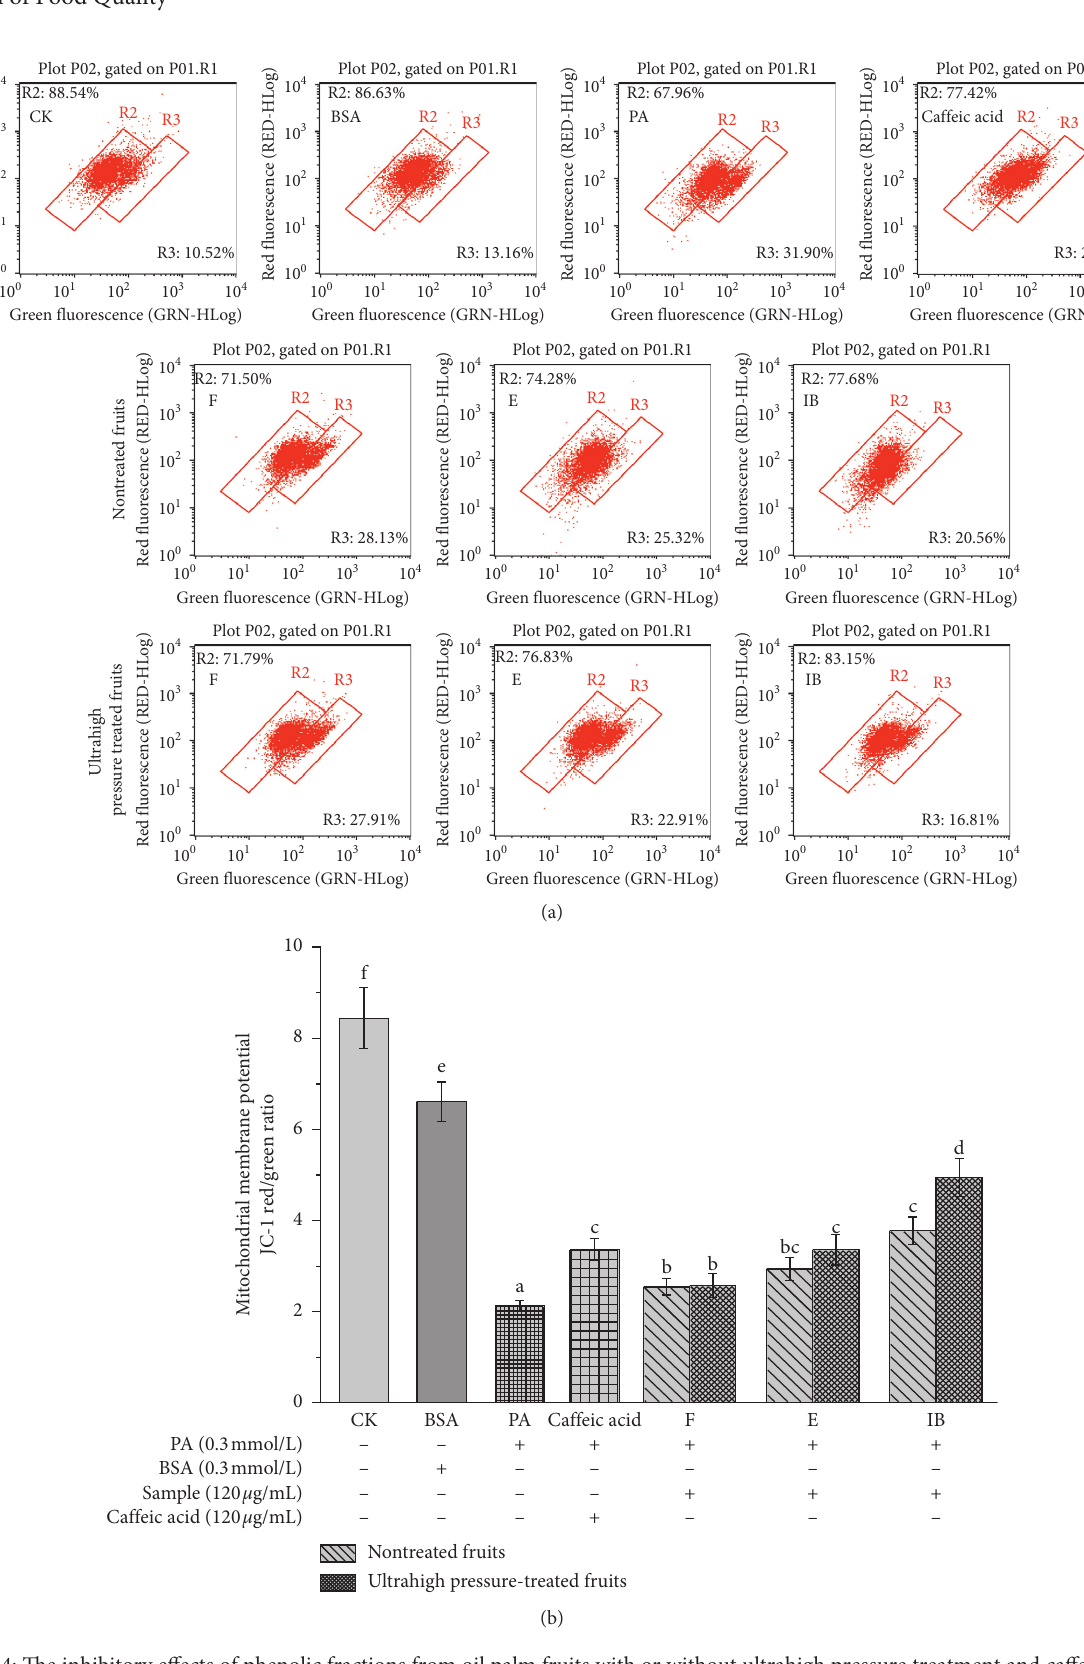
Figure 4: The inhibitory effects of phenolic fractions from oil palm fruits with or without ultrahigh pressure treatment and caffeic acid on PA-induced MMP depolarization: (a) flow cytometry analysis, (b) the ratio of red fluorescence to green fluorescence of different groups. Data are expressed as mean ± SD ( n � 3). In Figure 4(b), mean values with different letters are significantly different ( p < 0 . 05). CK: control group; BSA: BSA/NaOH complex solution; PA: PA/BSA complex solution; MMP: mitochondrial membrane potential; “F” free phenolic fraction; “E” esterified phenolic fraction; “IB” insoluble-bound phenolic